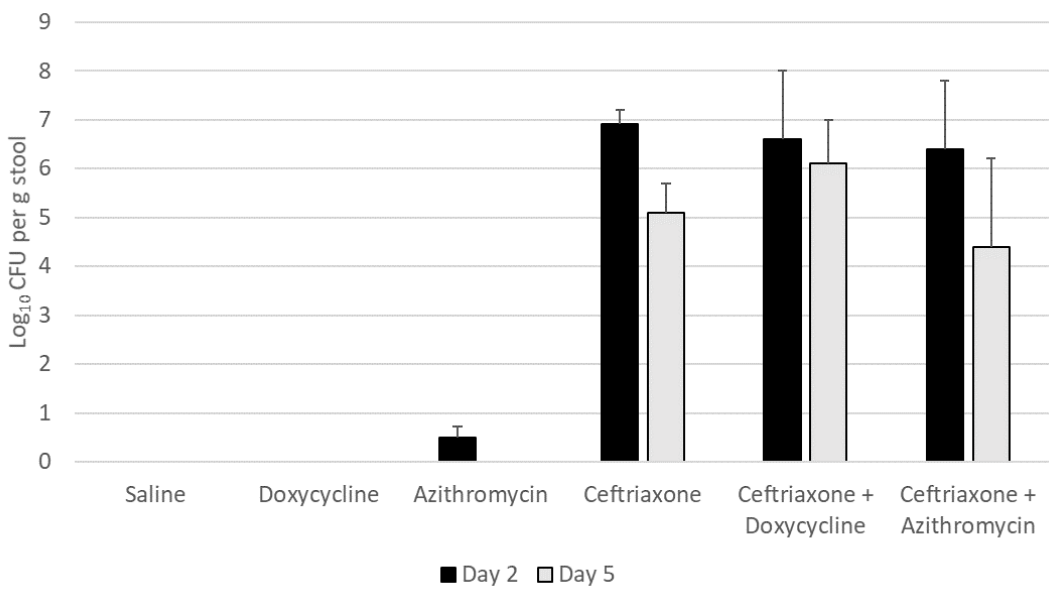
Figure 1: Effect of antibiotic treatment on establishment of colonization by Clostridioides difficile . Mice (5 per group) received 10,000 colony-forming units (CFU) of C. difficile VA17 (A) or 368 (B) on day 2 of 5 of daily antibiotic treatment. The concentration of C. difficile in stool was measured 2 days after gavage of the C. difficile test strain. Error bars represent standard